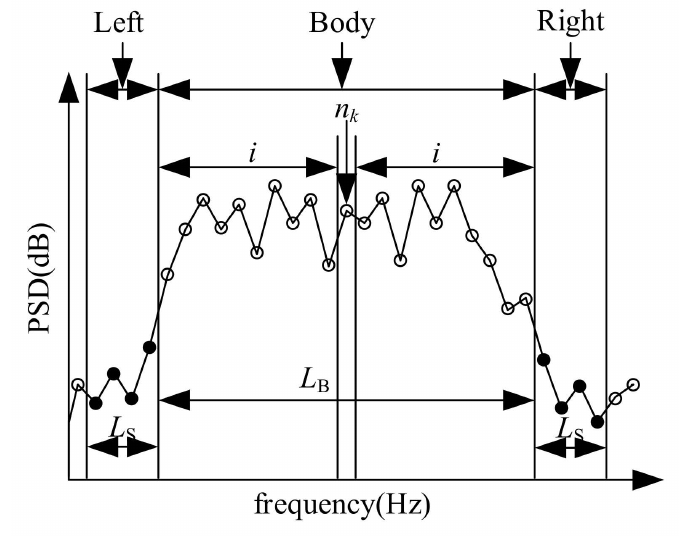
Figure 3. Schematic of DLE.